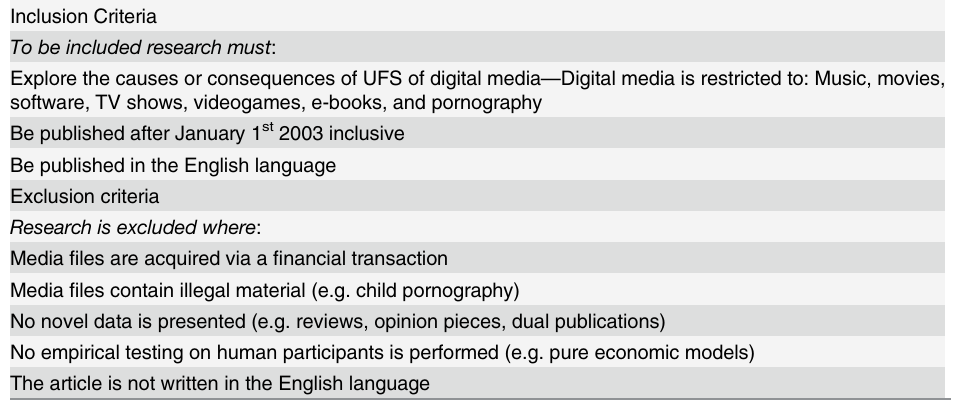
Table 3. Summary of inclusion and exclusion